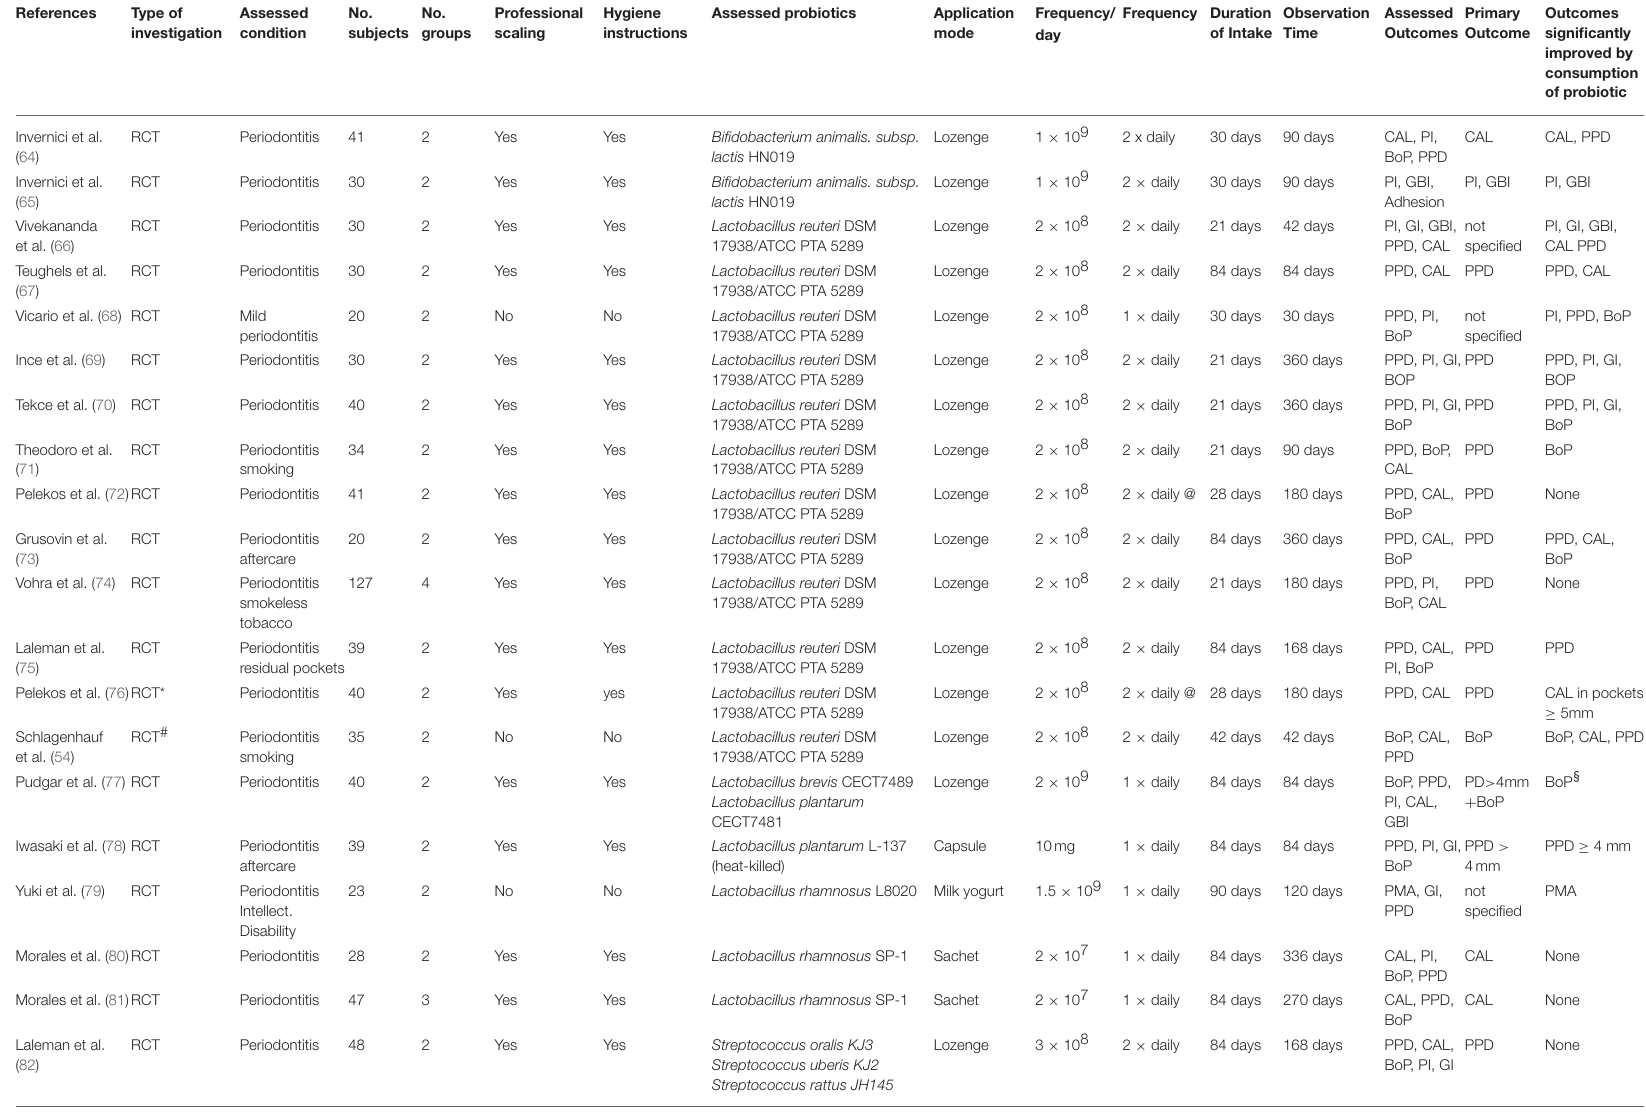
TABLE 2 | Randomized controlled clinical trials evaluating the use of probiotics in the management of